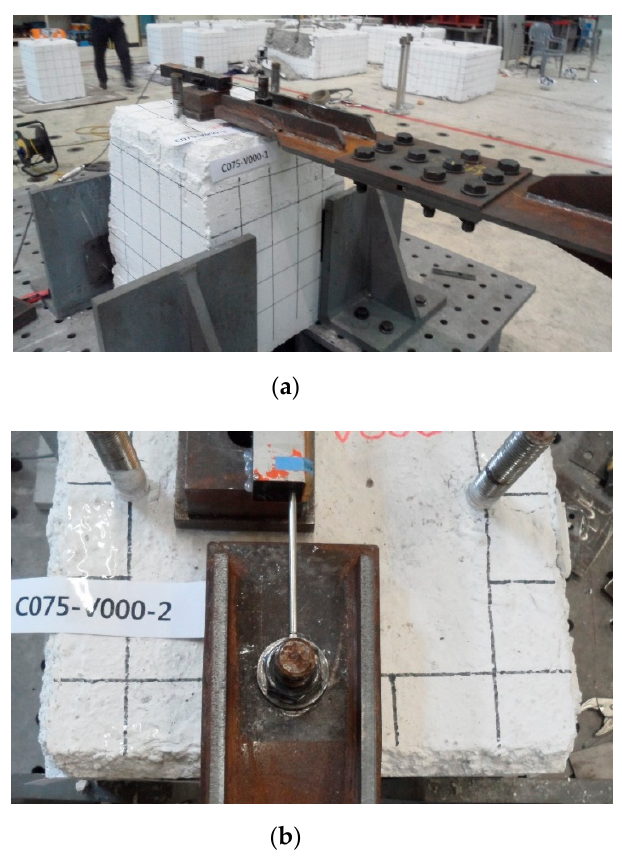
Figure 2. Test setup and instrumentation of the anchor specimen: ( a ) shear test setup; ( b ) linear variable differential transformer (LVDT) installed on the anchor.